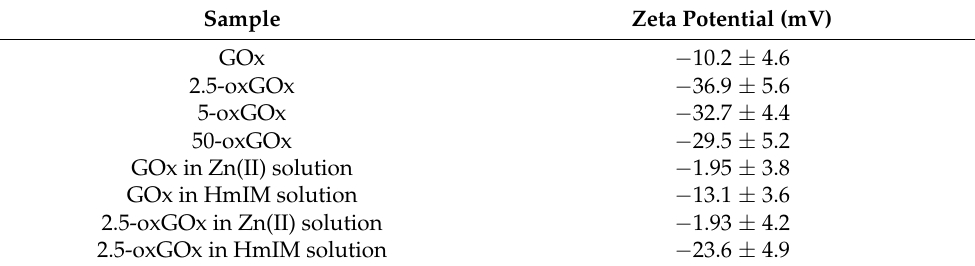
Table 1. Experimental zeta potential of the tested protein solutions 1